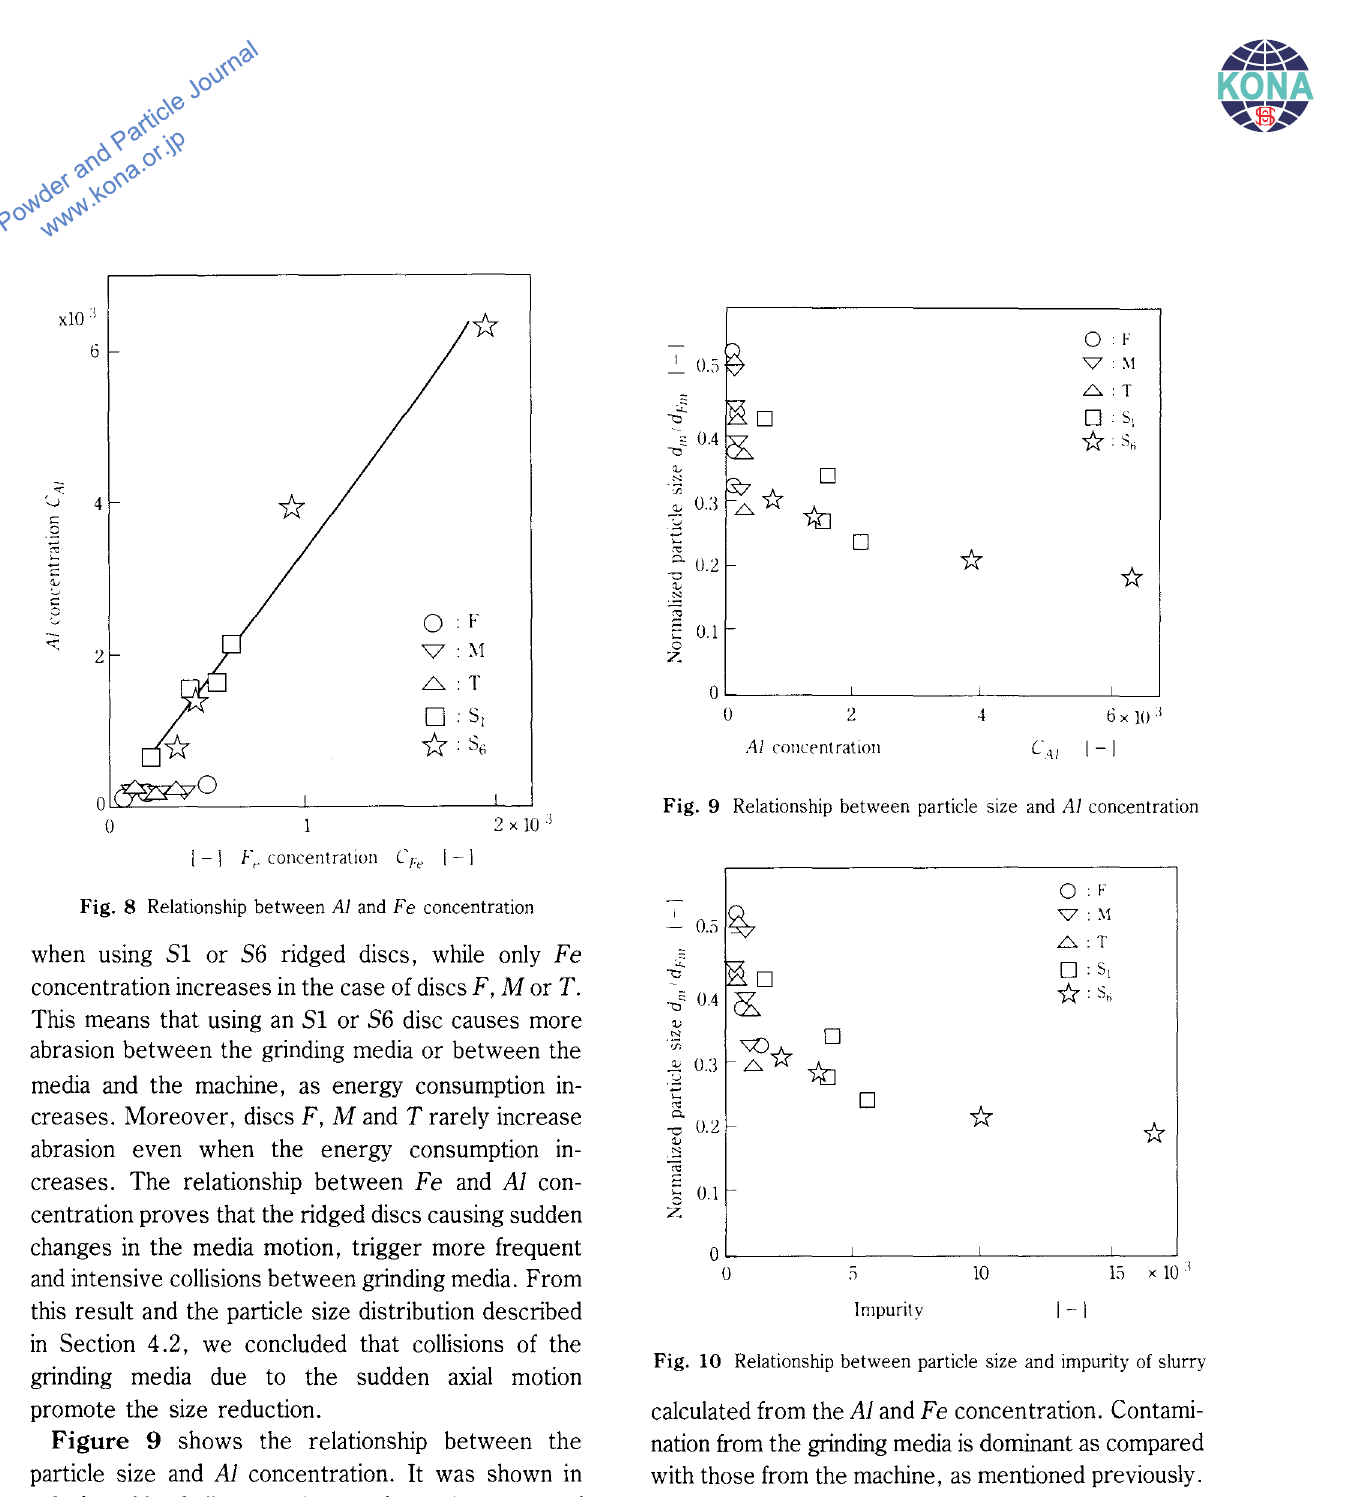
Fig. 10 Relationship between particle size and impurity of slurry calculated from the AI and Fe concentration. Contami nation from the grinding media is dominant as compared with those from the machine, as mentioned